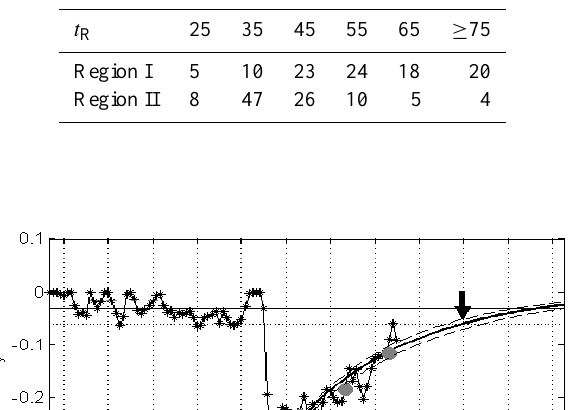
Table 2. Relative frequencies (%) of different classes of recovery time, t R , (in months) with respect to Regions I and II.